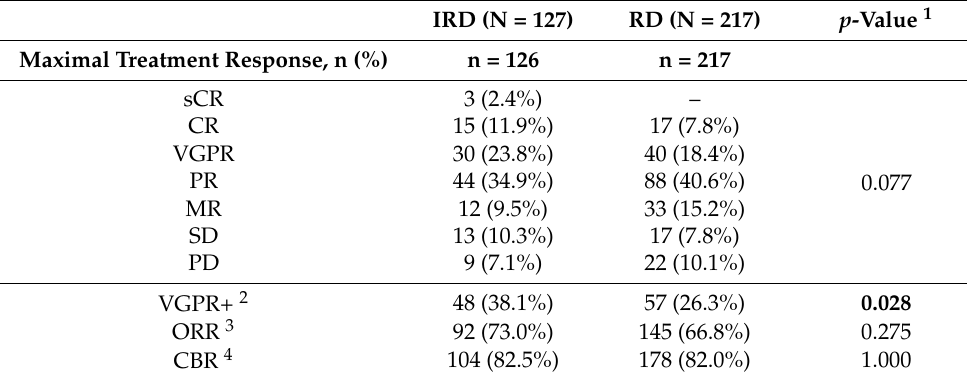
Table 1. Maximal treatment response.